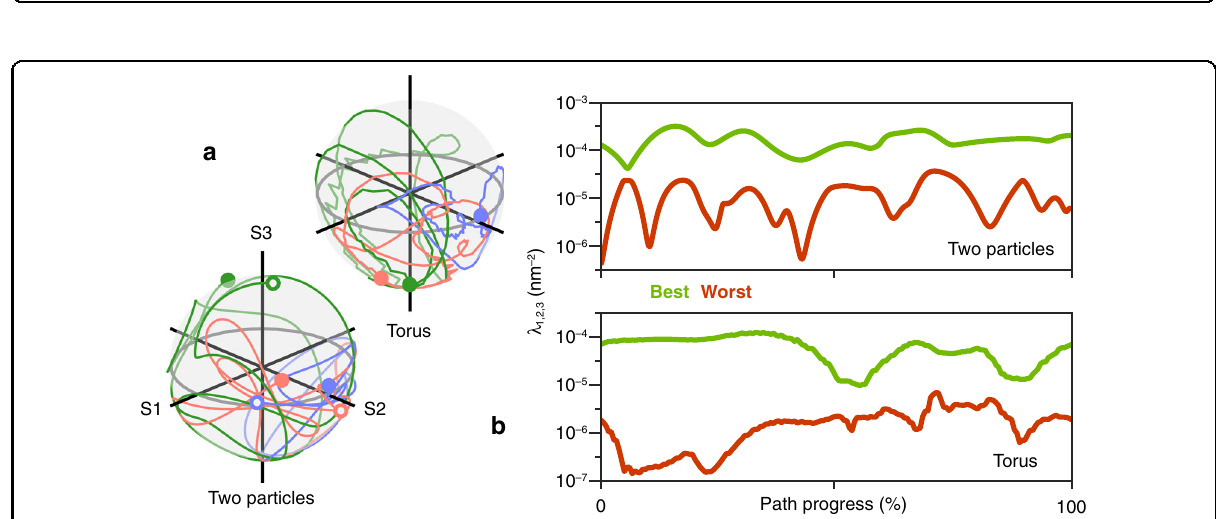
Fig. 4 Characterisation of incident fi elds and cold spots a Poincaré spheres showing the changes in each plane wave ’ s polarisation (red line: E a , blue line: E b ) as the cold spot is moved along the two-particle and torus paths. The hollow and fi lled circles represent the start and end polarisations for the cold spot path (these are the same for the torus). The green line gives the relative phase and amplitude between the plane waves on a superimposed Bloch sphere. The axes are S1 ¼ x m j j 2 (cid:2) x n j j 2 , S2 ¼ 2Re x m x (cid:4)